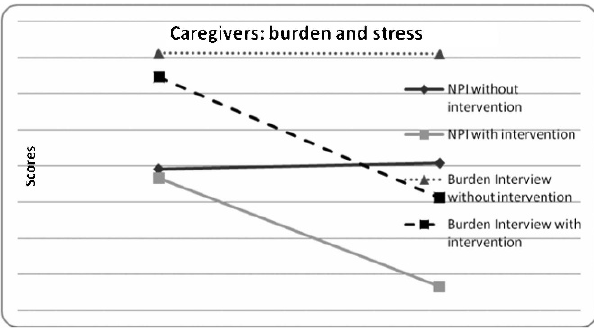
Figure 3 - Impact of motor intervention performed by patients on caregivers burden and stress according to Neuropsychiatric Inventory and Burden